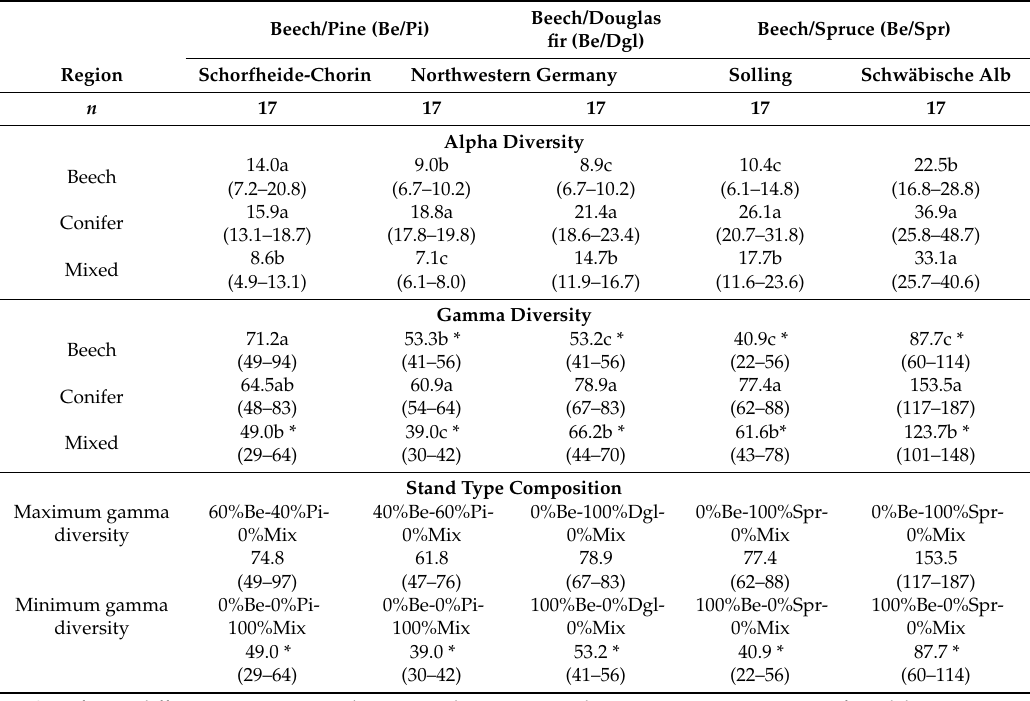
Table 2. Alpha and gamma diversity (species richness) of vascular plants in pure beech, pure conifer and mixed stands (=corners of the triangle in Figure 1), and the composition of pure and mixed stands within hypothetical forest landscapes that supports maximum and minimum gamma diversity of vascular plants. Given are mean values of the 1000 resamplings based on 17 plots per resampling. Minimum and maximum resampling values are given in parenthesis a . Beech/Douglas Beech/Pine (Be/Pi) fir